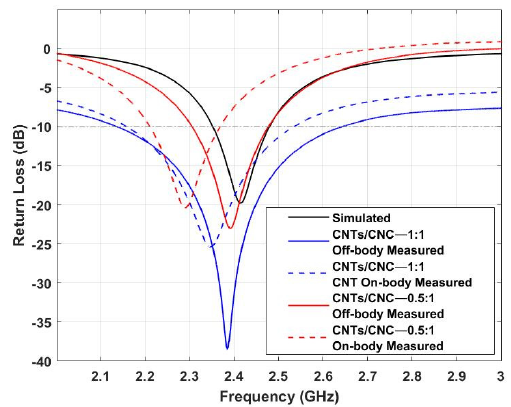
Figure 14. Simulated vs. Measured S 11 of CNTs/CNC LOOP antennas in off- and on-body settings.